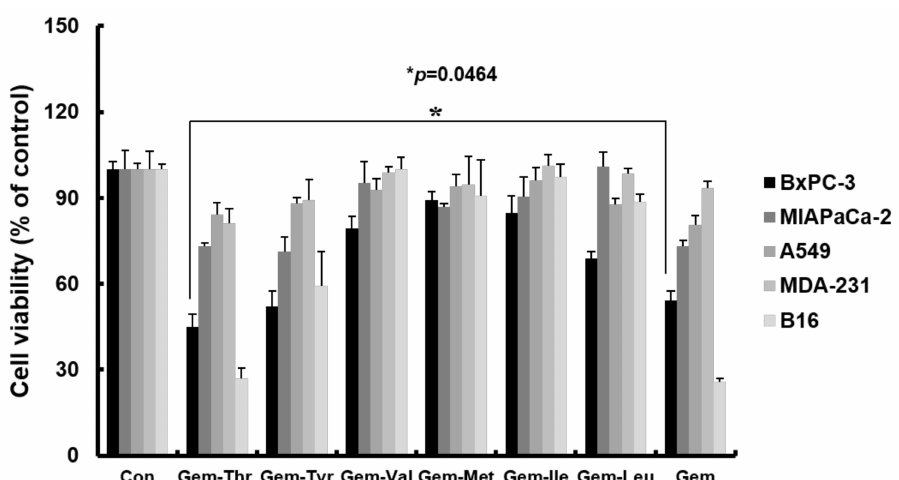
Figure 3. Growth-inhibitory effects of gemcitabine and of its amino-acid-conjugated derivatives on BxPC-3, MIAPaCa-2, A549, MDA-MB-231 B16 cells after exposure to 1 µ M concentrations for 48 h,